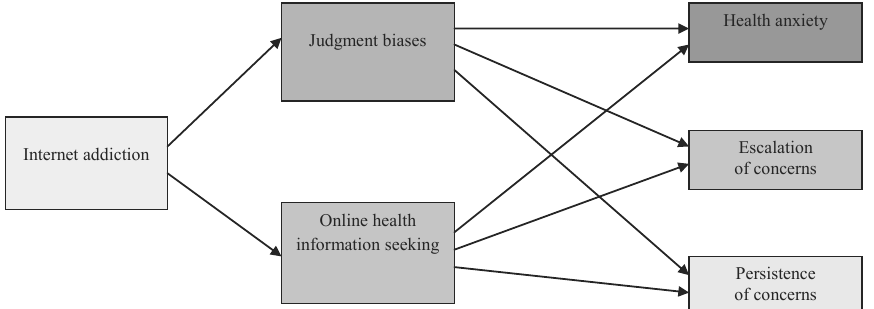
Fig. 4. Graphic model of the mediated in (cid:223) uence of Internet addiction on anxiety aroused by online health information seeking, escalation and persistence of health concerns with mediators judgment biases and extent of online health information seeking Source: Own